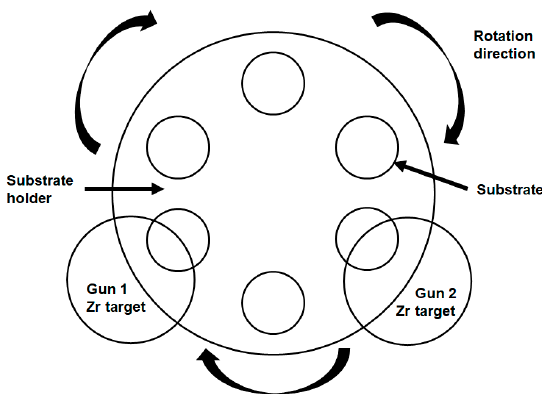
Figure 1. Relationship of sputter targets to the sample positions. Table 1. Chemical composition and deposition rates of ZrN x films prepared using various N 2 flow ratios.